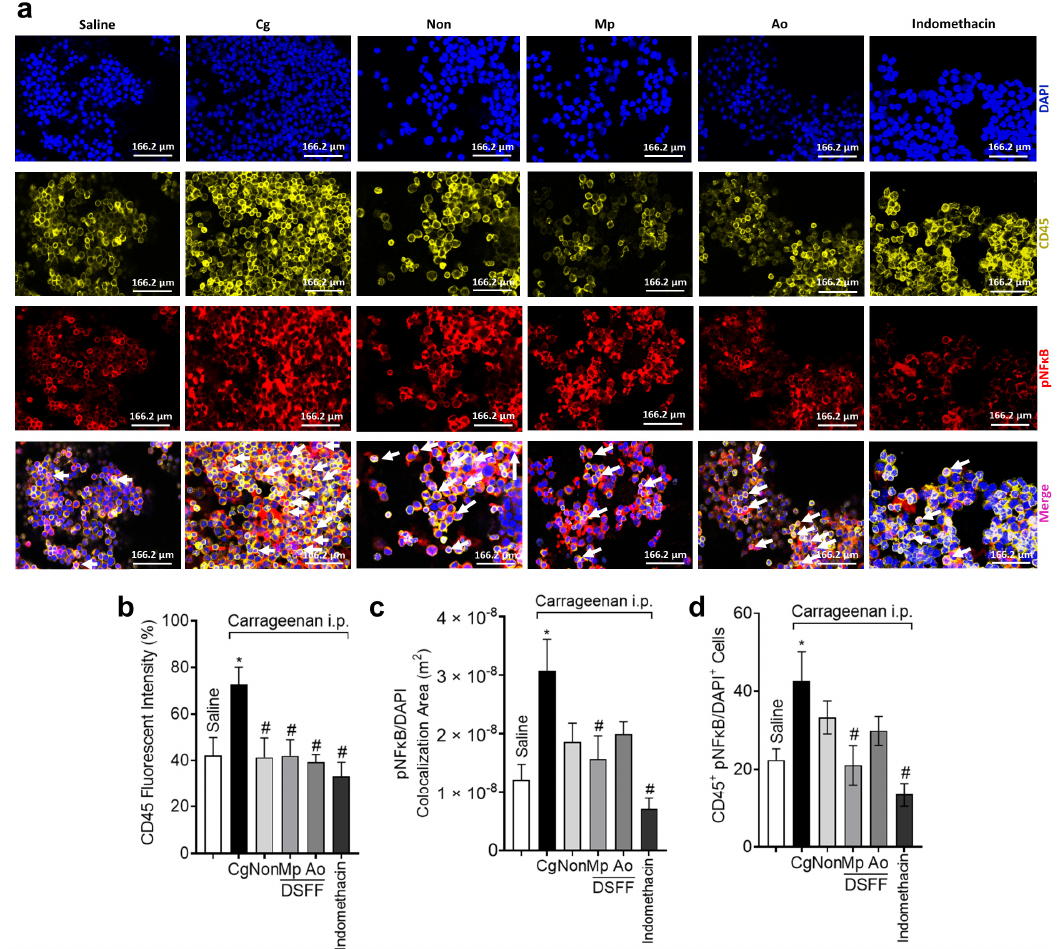
Figure 6. Recruitment of CD45+ hematopoietic cells and activation of NF κ B in the peritonitis model. DSF-Non, DSFF-Mp, and DSFF-Ao (30 mg/kg) extracts inhibits ( a ) and ( b ) CD45 fluorescent intensity. DSFF-Mp extract inhibit a and ( c ) pNF κ B colocalization area with DAPI (a nuclear marker), and ( a ) and ( d ) CD45 + pNF κ B/DAPI + cells in the peritoneal